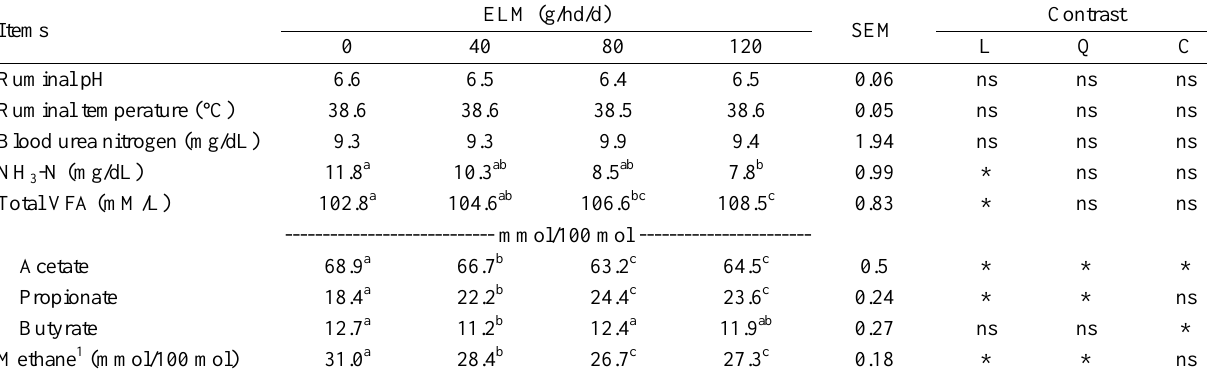
Table 3. Effect of Eucalyptus leaf meal on rumen fermentation characteristics Items